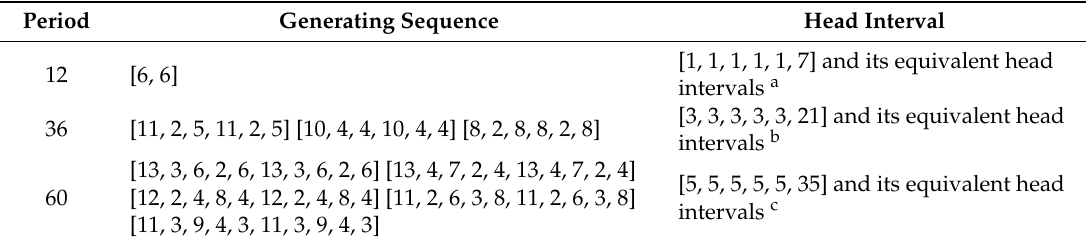
Table A2. Complete result of length 6 self-dual necklace ordering STGCs.